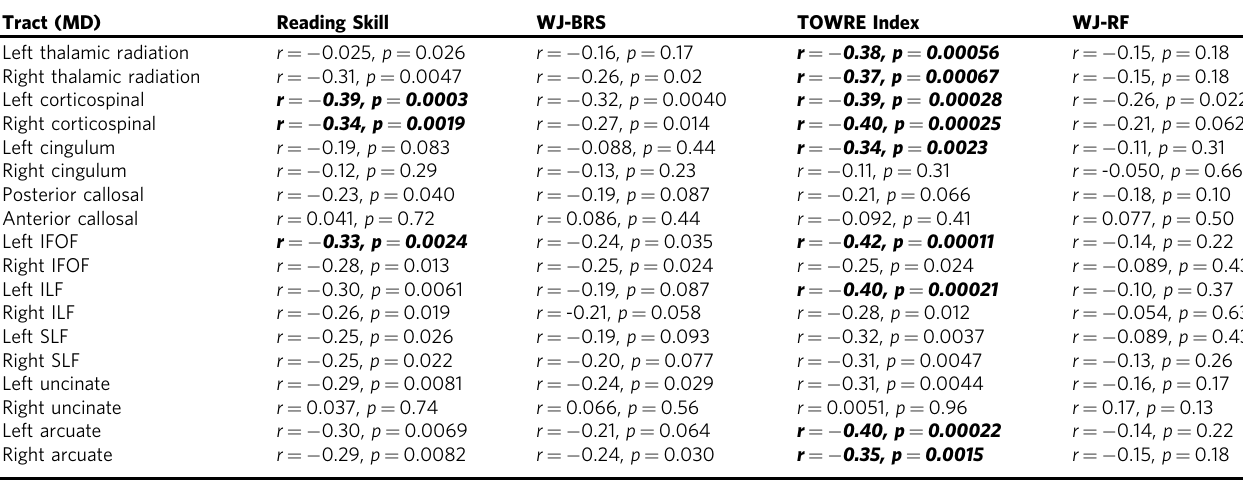
Table 1 White matter properties track changes in Reading Skill Tract (MD) Reading Skill WJ-BRS TOWRE